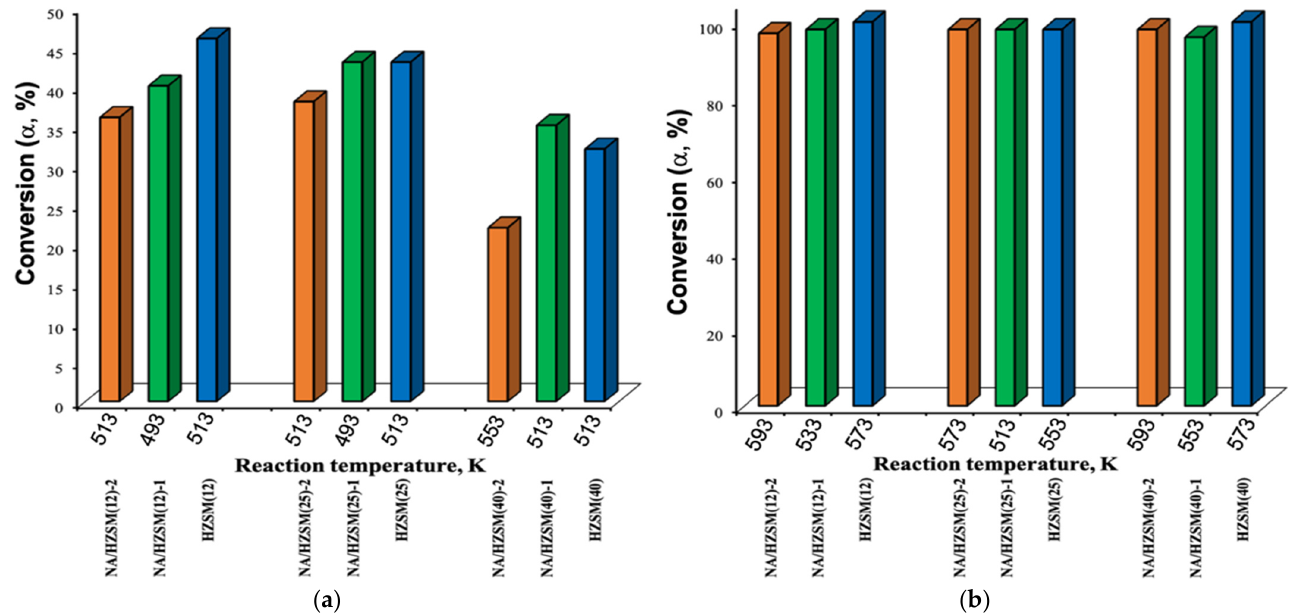
Figure 14. Conversion of ethanol ( α , %) to diethyl ether ( a ) and ethylene ( b ) for HZSM and NA/HZSM-1,2 (data from [16] ). HZSM(25) with the highest S DEE ,% (513 K) (Table 10) has maximum content of bridg- ing hydroxyls Si-OH-Al(Fe) and terminal silanol groups Si-OH (FTIR data, Figure 6), max- (Table S3).